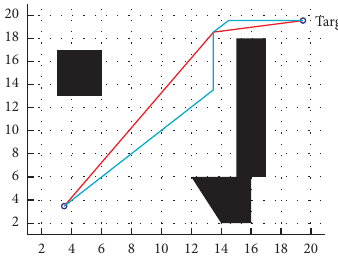
Figure 12: The generation process of greedy strategy curve.